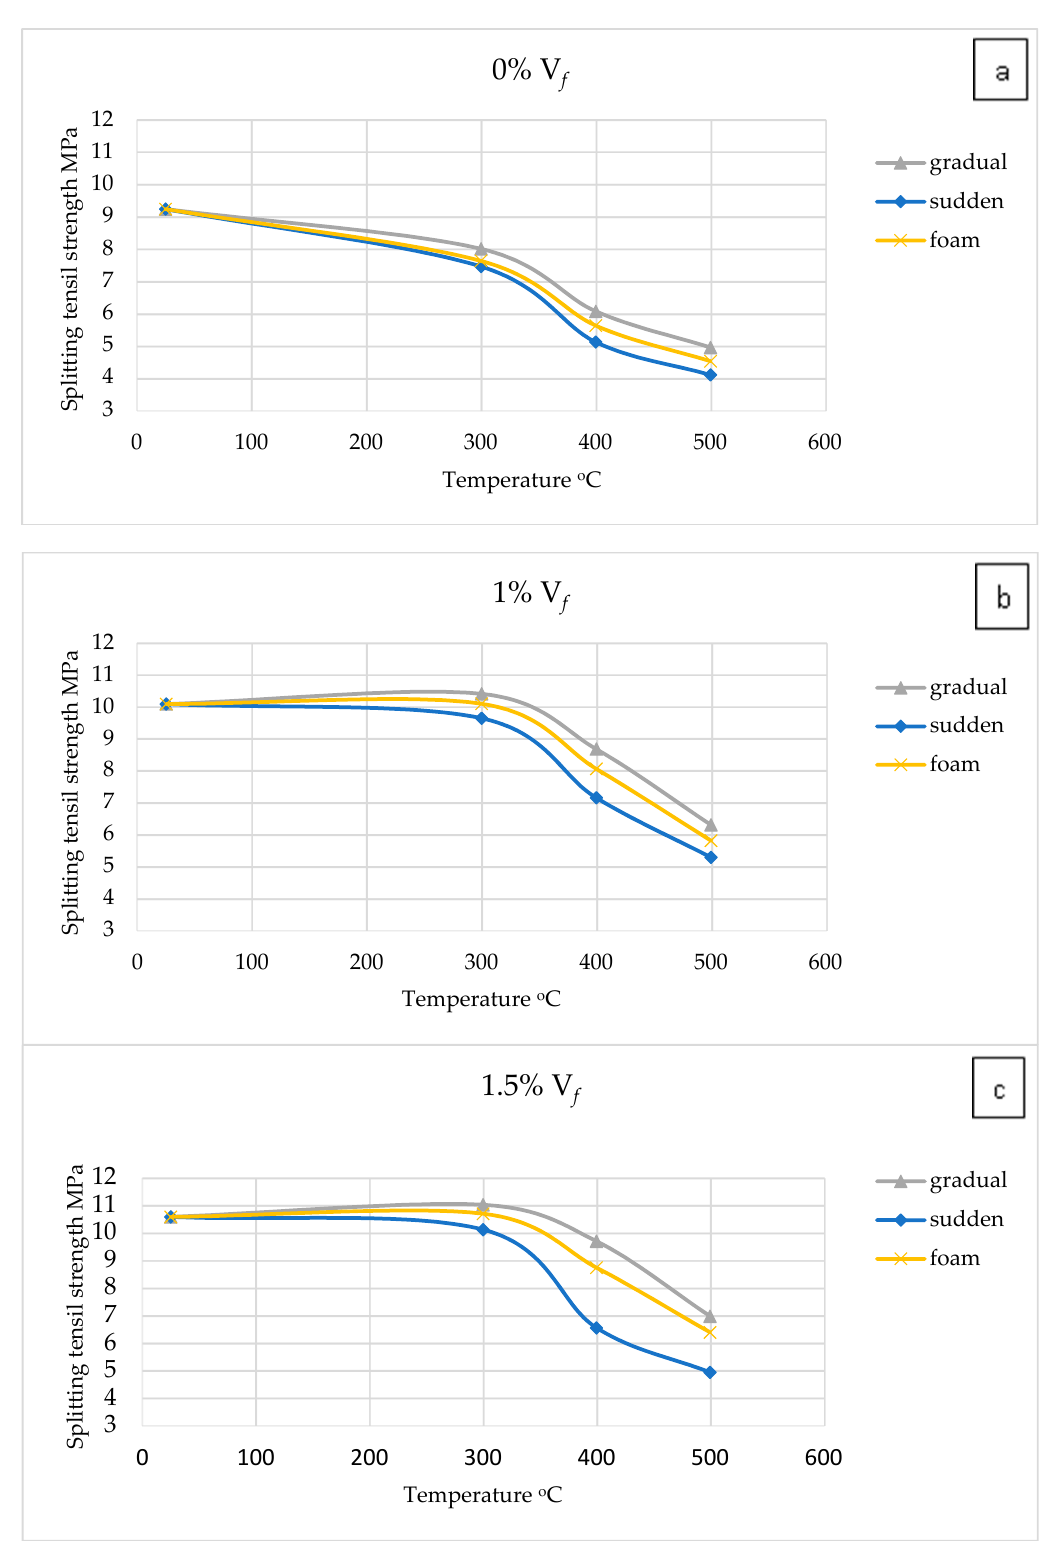
Figure 8. Splitting tensile strength concerning all burning temperatures and cooling methods: ( a ) For 0% V f ; ( b ) For 1.0% V f ; and ( c ) For 1.5% V f .